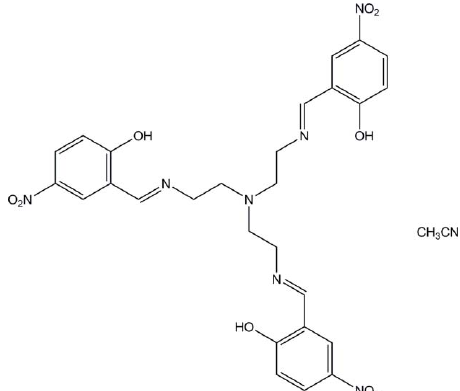
For the crystal structure of tris{2-[(5-bromosalicylidene)- amino]ethyl}amine, see: Kanesato et al. (2001).